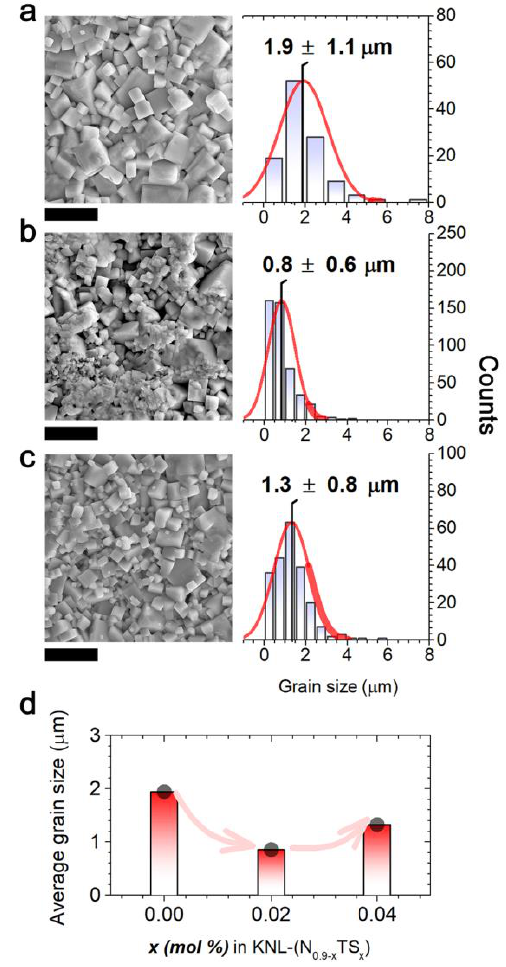
Figure 3. Effect of Sb doping on microstructure. ( a – c ) FE-SEM images (with their respective grain size distributions, GSDs) showing the evolution of the microstructure in the KNL − (N 0.9 − x TS x )) ceramics as a function of the Sb content, where ( a ) corresponds to x = 0.00, ( b ) to x = 0.02, ( c ) to x = 0.04. Scale bar, 10 µ m. ( d ) Evolution of the average grain size with antimony addition.